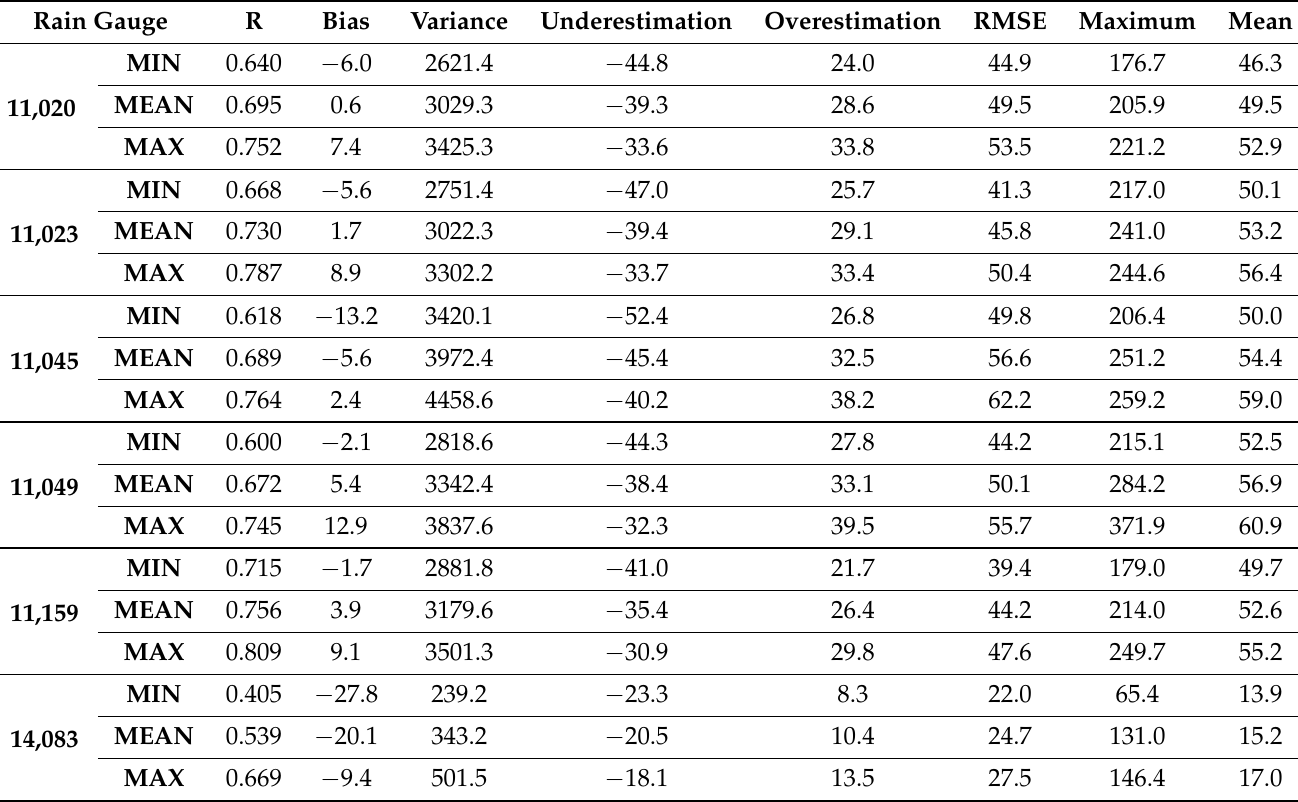
Table 5. Minimum, mean, and maximum coefficients of the monthly rainfall outputs for the Monte Carlo iterations, using random generator